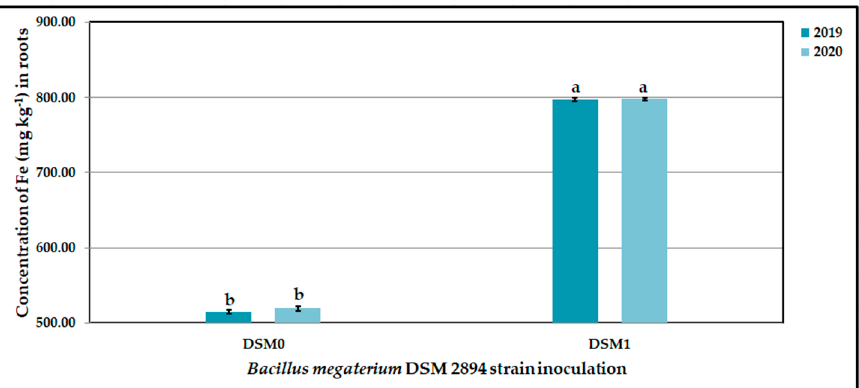
Figure 13. Influence of Bacillus megaterium DSM 2894 var. on root iron (Fe, mg kg − 1 ) contents of CaCO 3 ‐ stressed sweet potato plants in 2019 and 2020 seasons. Bars with a different letter indicate significant difference between treatments at p ≤ 0.05. DSM 0 = non ‐ inoculated with Bacillus megaterium DSM 2894 var., DSM 1 = inoculated with Bacillus megaterium DSM 2894 var.